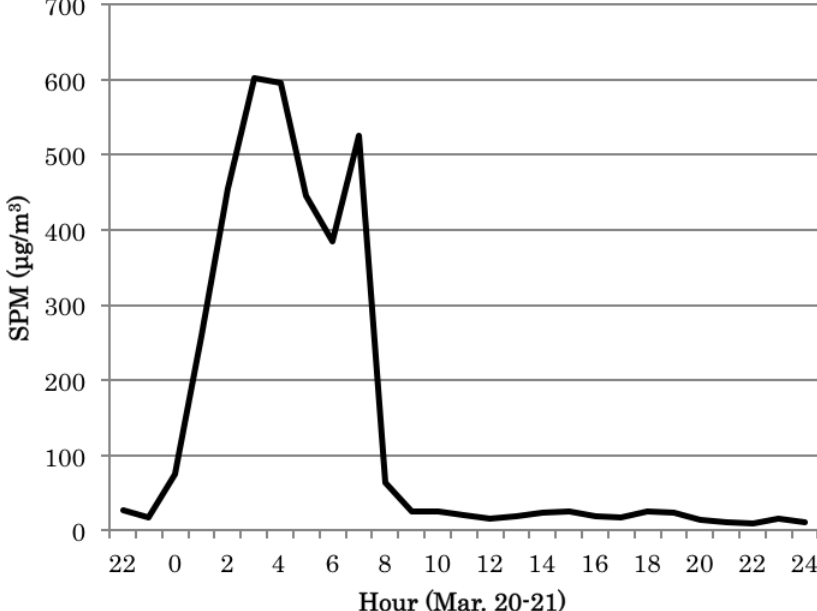
Figure 2. Time series of hourly SPM levels from the 20th to 21st of March 2010.